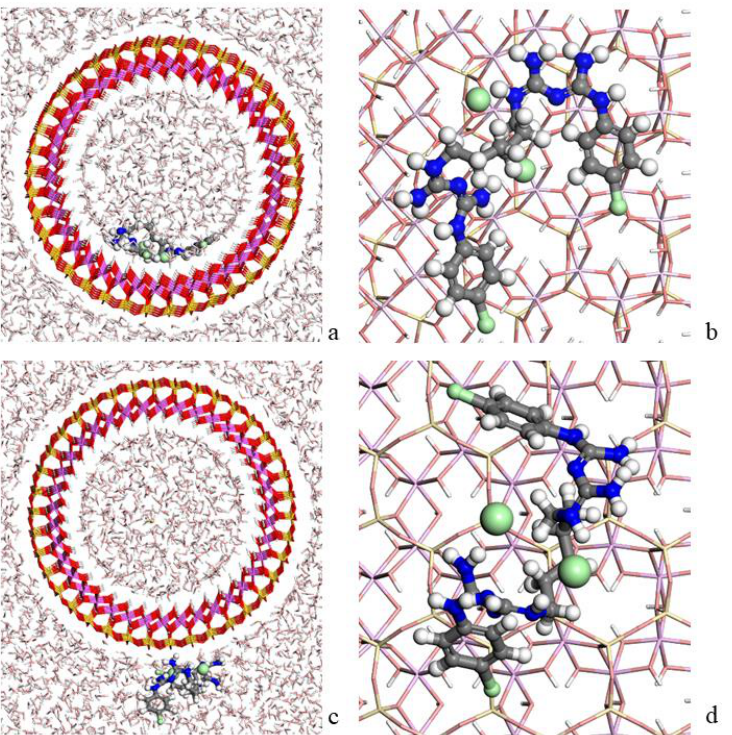
Figure 10. Complex of the CHX drug adsorbed on the internal ( a , b ) and external ( c , d ) surface of HAL nanotube from different views and with ( a , c ) and without ( b , d ) water solution. The atoms of silicon, aluminum, oxygen, hydrogen, carbon, nitrogen and chlorine are presented in yellow, pink, red, white, grey, blue and light green, respectively.